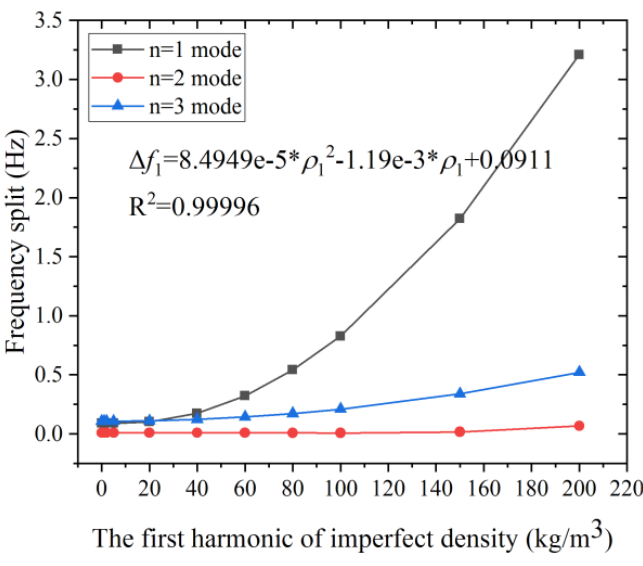
Figure 4. The effect of ρ 1 on the frequency split of the n = 1, 2, and 3 modes. Figure 5 shows that the frequency split of the n = 1 mode increases rapidly with the growth of the second harmonic error, while that of the n = 2 and the n = 3 mode increase only mildly. For example, the frequency split of n = 1 mode reaches 38.67 Hz when ρ 2 is 65 kg/m 3 , while the frequency split of the n = 2, 3 mode is only 1.19 Hz and 0.99 Hz, respectively. The frequency split of n = 1 mode is severely affected by ρ 2 compared with the other two modes, even when the defect is small. Moreover, ∆ f 1 grows linearly with the increase of ρ 2 , as illustrated by the grey line and the least-square fit. Therefore, this simulation result is consistent with (5). Nearly 95% of the frequency split ∆ f 1 comes from the second harmonic error when ∆ ρ 2 is 2.95%. The frequency split ∆ f 1 can be used for the evaluation of the second harmonic error. As we obtain the frequency split ∆ f 1 , the value of the ρ 2 can be calculated from the fitted formula. The simulation result shown in Figure 6 indicates that the frequency split of the n = 3 mode is proportional to the square of the third harmonic error. The influence of ρ 3 on the n = 1, 2 mode is rather small compared that on the n = 3 mode. The frequency split of the n = 1 mode keeps almost unchanged at 0.089 Hz. And the frequency split of n = 2 mode stay constant at 0.0096 Hz. Therefore, it is reasonable to consider that the third harmonic error has no impact on the frequency split of the n = 2, 3 mode. The frequency split of n = 3 mode is approximately proportional to the square of the third harmonic error when the second harmonic error is more than 40 kg/m 3 , as shown in the curve fit of ∆ f 3